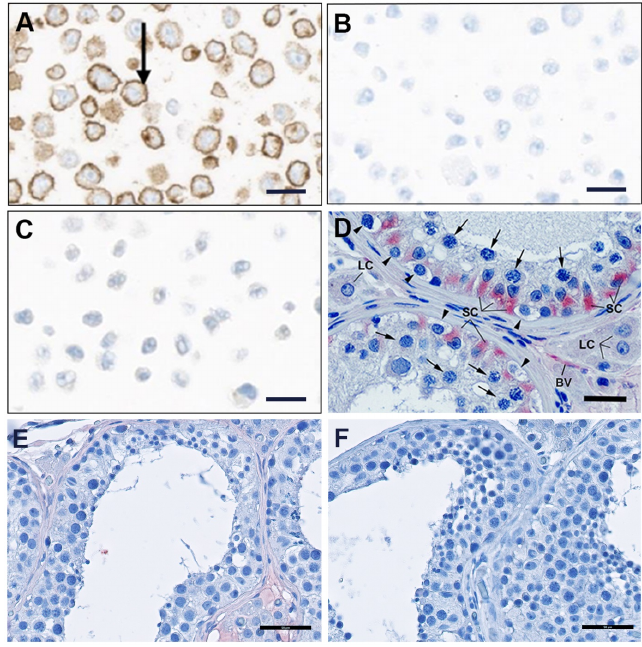
Figure 6. Immunocytochemical and immunohistochemical detection of FSHR on paraffin embedded cells and tissues. ( A – C ): Binding of FSHR323 to cell-presented hFSHR. Immunocytochemical analysis was performed on paraffin-embedded sections of Flp-In CHO/FSHR using FSHR323 antibody, followed by a secondary peroxidase-coupled antibody visualized by the brown peroxidase-reaction product of diaminobenzidine (DAB). ( A ): Strong membranous anti-FSHR staining of Flp-In CHO/FSHR (arrow); ( B ): The isotype control (mouse IgG2a) was completely negative; ( C ): No staining was seen in parental Flp-In CHO. D-F: FSHR expression in human testis tissue; ( D ): The receptor was detected by immunohistochemistry using the mouse FSHR323 monoclonal antibody followed by a secondary peroxidase-coupled antibody visualized by the red peroxidase-reaction product of aminoethyl carbazole (AEC). This method indicated that, in seminiferous tubules, only Sertoli cells (SC) express FSHR. Testicular blood vessels (BV) were also positive. Spermatogonia (arrowheads), pachytene spermatocytes (arrows), and Leydig cells (LC) were FSHR-negative. No FSHR-signal was visible in human testis with sc-7798 ( E ) and sc-13935 ( F ) antibodies. The scale bar represents 20 µ m in panels A, B, and C, 25 µ m in panel D, and 50 µ m in panels E and